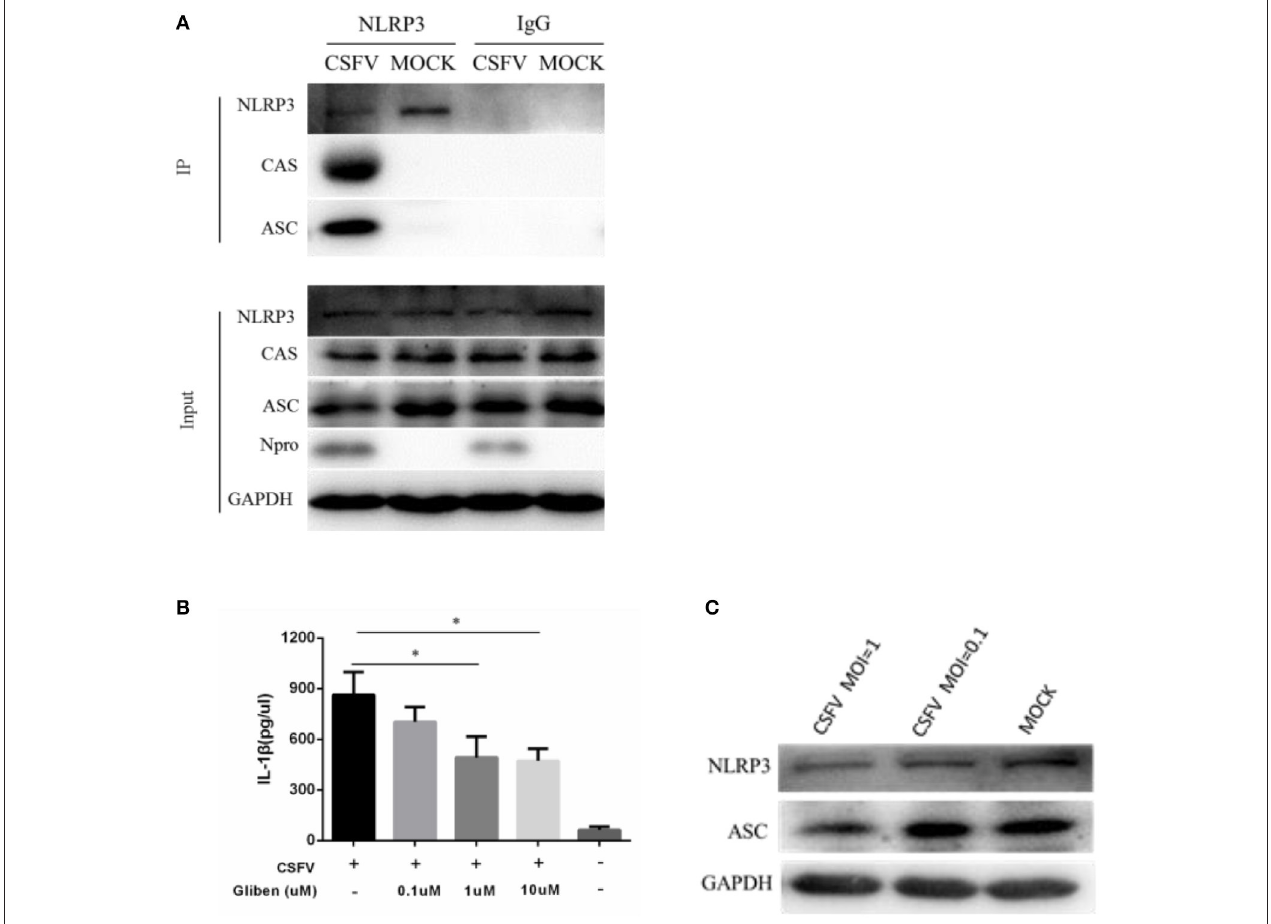
FIGURE 5 | Formation of the NLRP3 inflammasome was induced in PBMCs by CSFV infection. (A) PBMCs were mock-infected or infected with CSFV at an MOI of 1 for 48h. The cell lysate was collected and incubated with the anti-CAS and anti-ASC antibodies in order to immunoprecipitate (IP) caspase 1 (CAS) and ASC. Normal rabbit IgG was used as a negative control. Moreover, ASC and CAS protein levels in the lysates of whole cells were used as input controls. GAPDH was used as an internal loading control. CSFV infection was verified by immunoblotting using anti-CSFV Npro antibody. (B) The level of NLRP3 inflammatory complexes induced by CSFV infection was linked to ATP-dependent K + channel activation. (C) CSFV infection inhibited the expression of NLRP3 and ASC. * P < 0.05. P -values were calculated using an One-way ANOVA